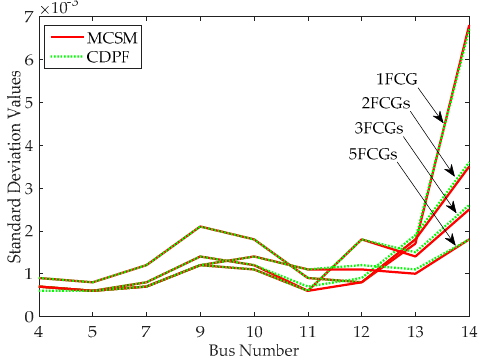
Figure 11. Standard deviations of the voltage magnitude at PQ buses with one, two, three and five FCGs, respectively, at different buses in an IEEE 14-bus power system.